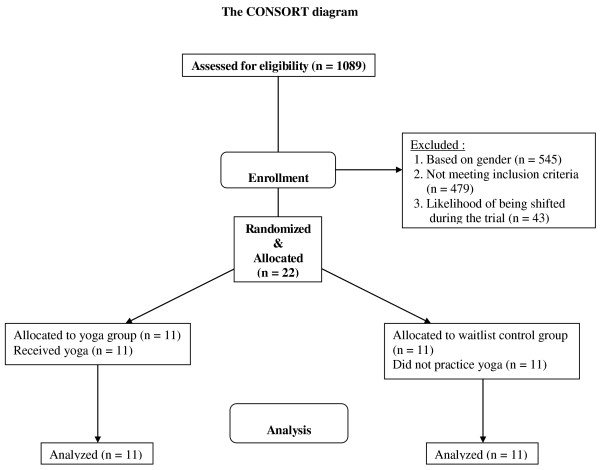
Consort diagram summarizing participant numbers and timing of randomization, assignment, interventions and assessments.